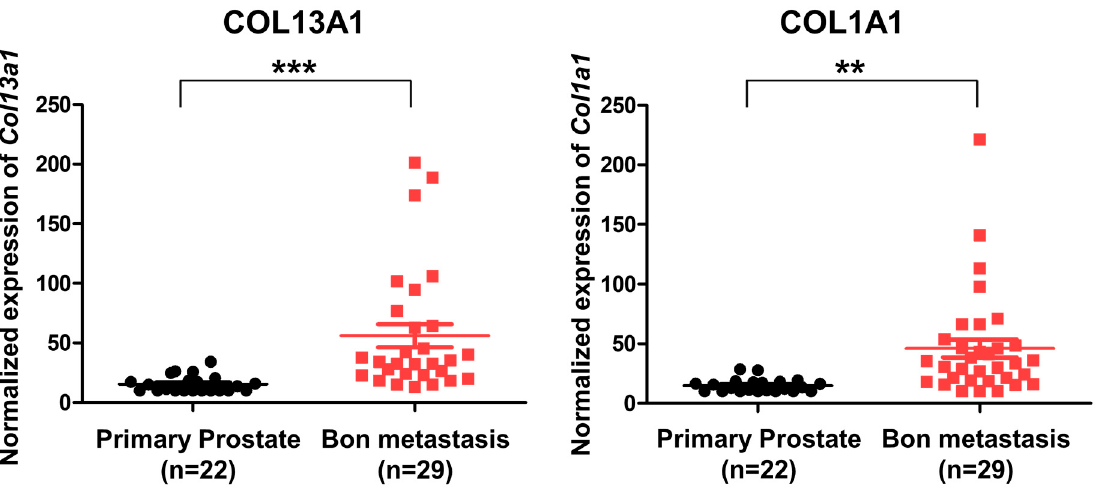
Figure 7. Expression of COL13A1 and COL6A1 in patients with primary localized prostate cancer and bone metastatic prostate cancer (GSE32269). The expression of COL13A1 and COL6A1 was high in DEGs of bone metastatic prostate cancer (cut-off value: log2FC > 2, p -value < 0.05). Data are mean ± SEM. ** p < 0.01, *** p < 0.001.